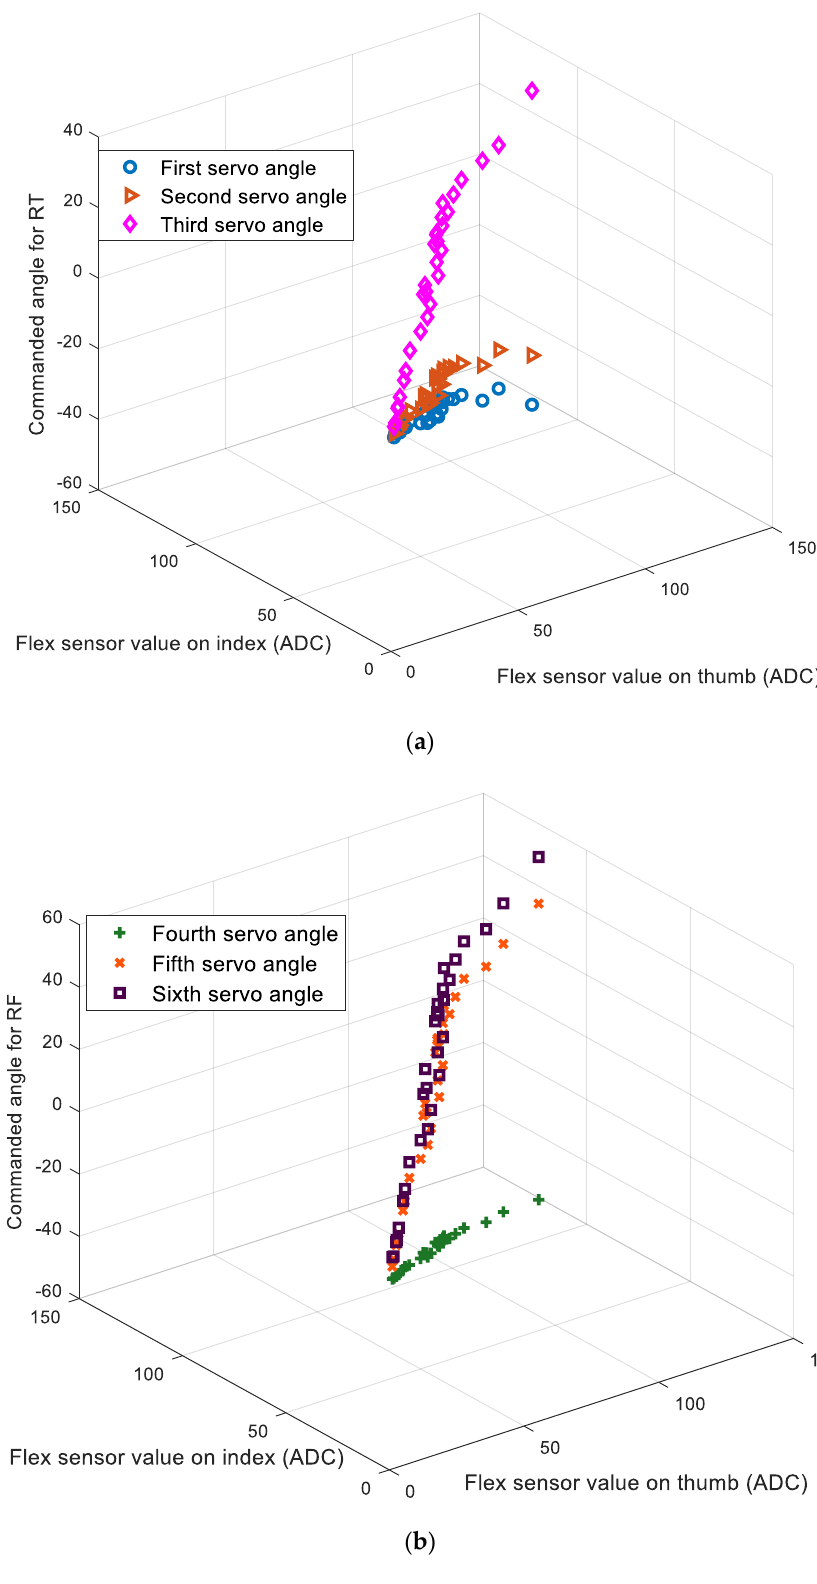
Figure 4. Data-driven posture map from flex sensor to servo motor-commanded angles: ( a ) Robotic thumb; ( b ) Robotic finger.